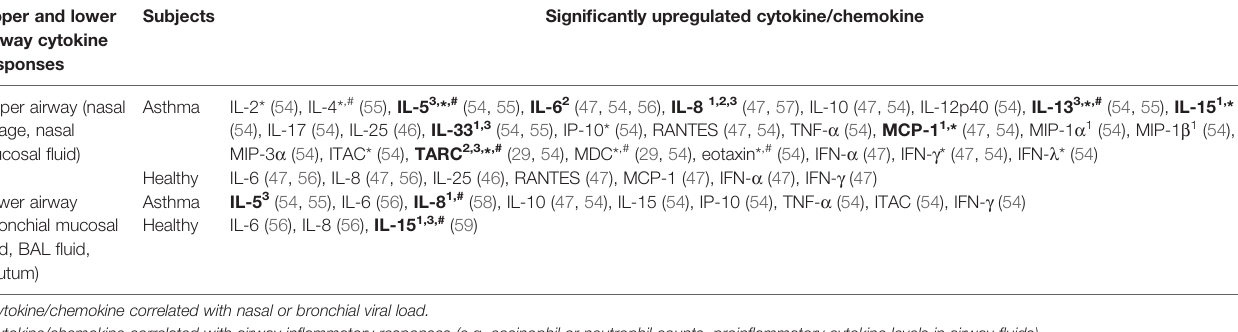
Signi fi cantly upregulated